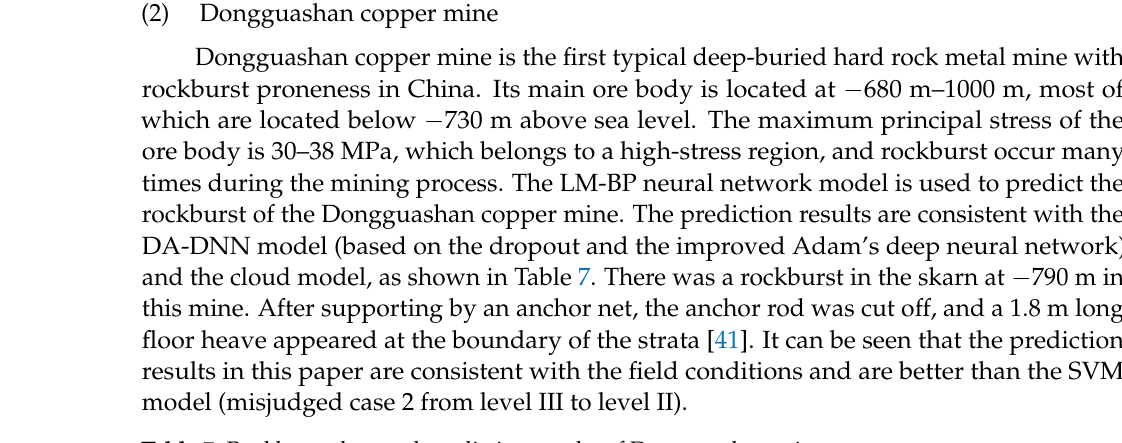
Table 7. Rockburst data and prediction results of Dongguashan